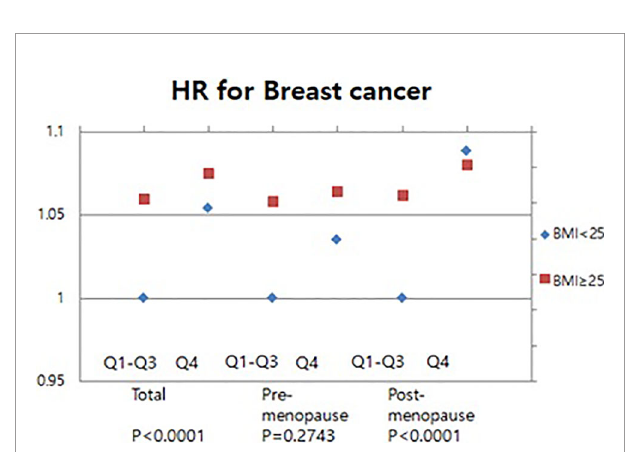
FIGURE 3 | Association of GGT levels with CIS risk in total subjects, pre-menopausal and post-menopausal women.